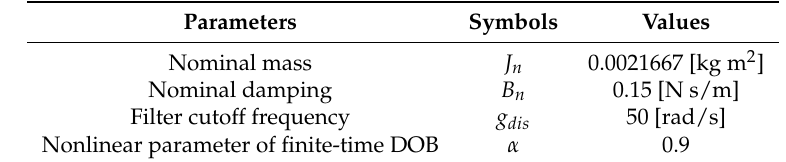
Figure 6. Experimental configuration. Table 1. The experiment